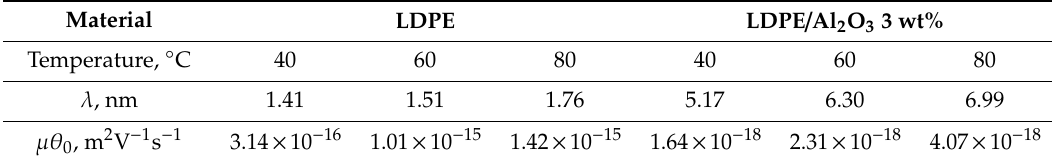
Figure 7. Plots of J vs. E for pure LDPE and LDPE / Al 2 O 3 3 wt% nanocomposite according to the Nath et al. model [26]. Markers are measured results and lines show the fitting. Table 4. Fitting parameters obtained by using the Nath et al. model [26].